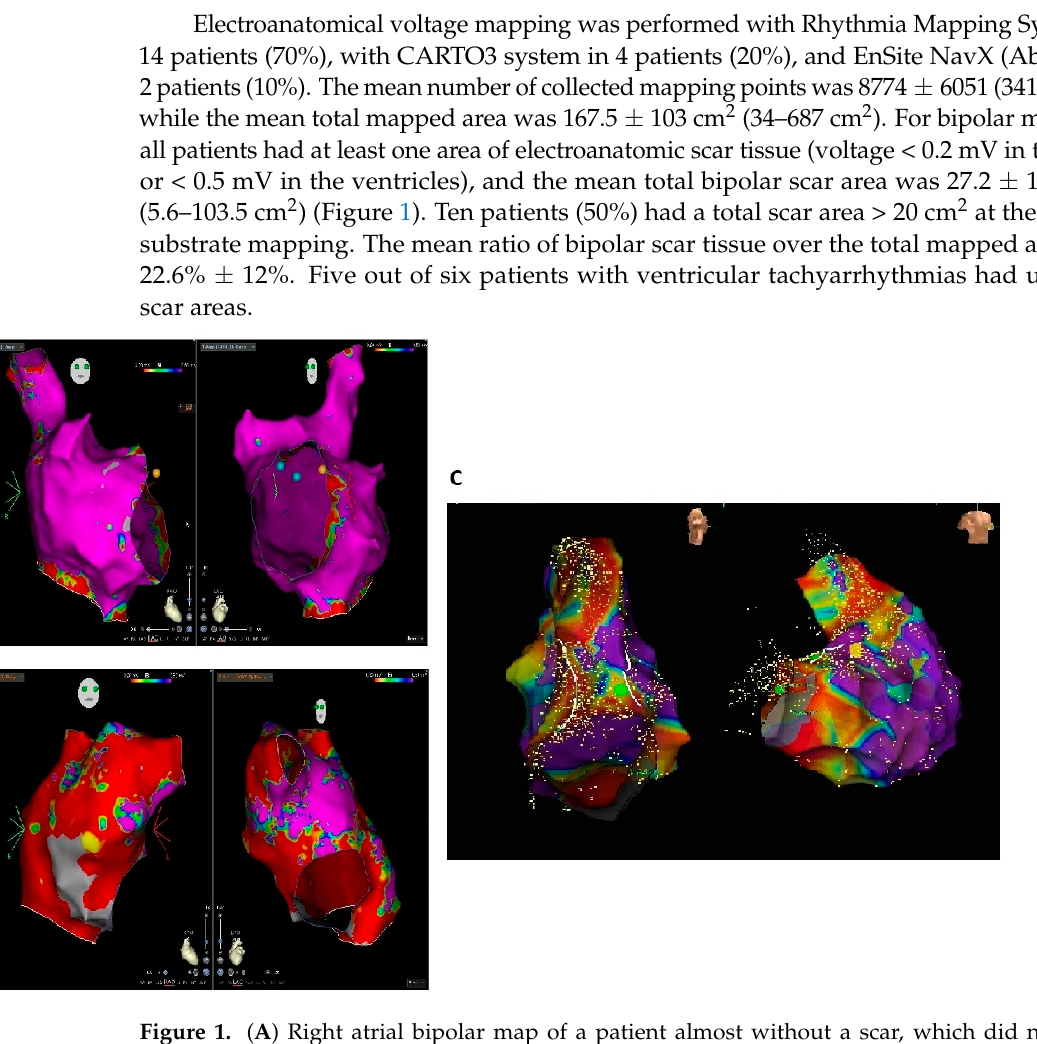
Figure 1. ( A ) Right atrial bipolar map of a patient almost without a scar, which did not show arrhythmia relapse of isthmus-dependent atrial flutter during follow-up. ( B ) Right atrial bipolar map of a patient with intra-atrial reentrant tachycardia and an extensive scar, who had arrhythmia recurrence. ( C ) Right ventricular bipolar map of a patient with ventricular tachycardia showing an extensive scar; the patient had arrhythmia recurrence during follow-up.